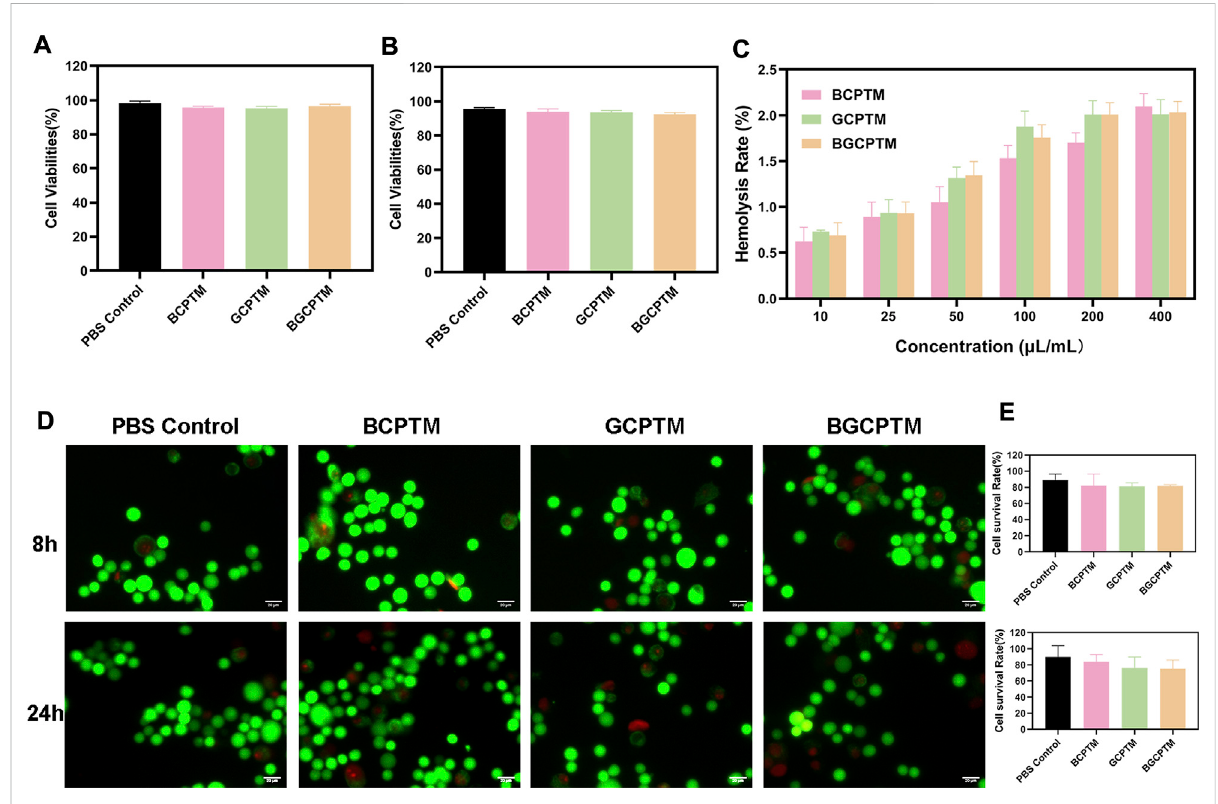
FIGURE 3 Invitro cytotoxicityevaluationanderythrocyteshemolysis. (A) CellviabilitiesofBCPTM,GCPTMandBGCPTMafterco-incubated8 h( n =3). (B) Cell viabilities of BCPTM, GCPTM and BGCPTM after co-incubated 24 h. (C) Erythrocytes hemolysis with different concentration. (D) Fluorescence images of HUVECs cells co-stained by calcein AM/PI after treated with different preparations. Live and dead cells displayed green and red signals, separately. Scale bar: 20 μ m. (E) Quantitative analysis of the cell survival rates in Panle (D)